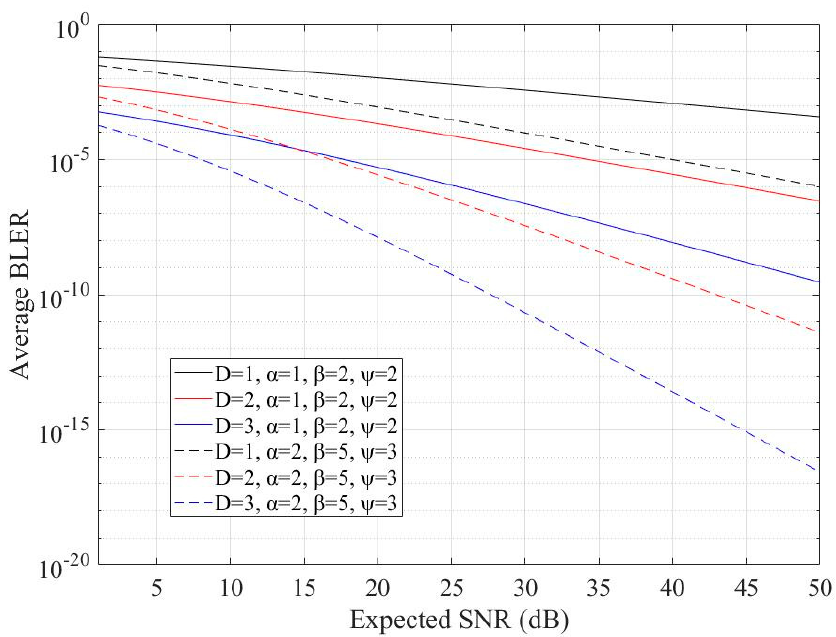
Figure 2. ABLER performance versus the expected SNR for M = 4, N = 5, and 4-PPM scheme.